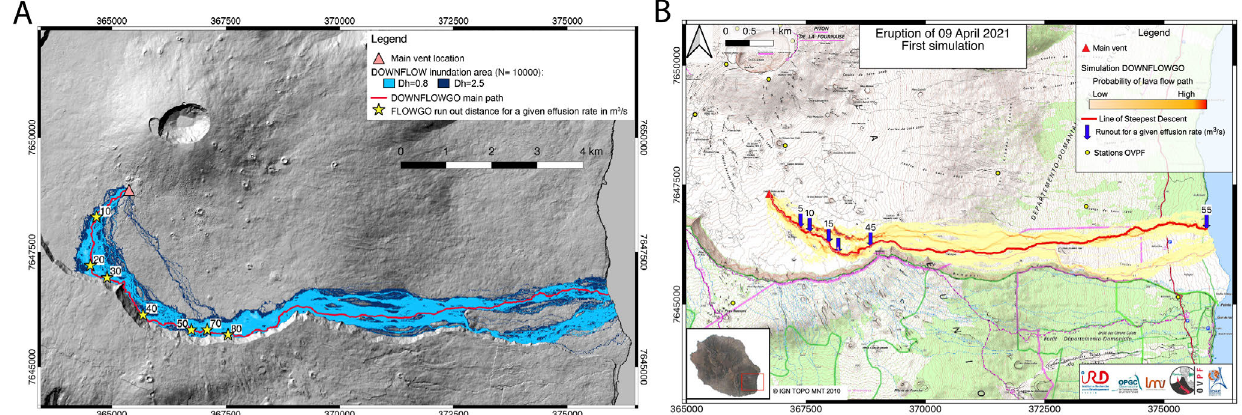
Figure 8: [A] The first map produced during the April 2018 eruption showing the lava flow inundation area (simulation with Δ h = 0.8 in light blue and Δ h = 2.5 in dark blue) and run out distances (yellow stars) for a given TADRs (numbers are in m 3 s − 1 ) along the LoSD descent (red line). The background is the hill-shaded 2010 LiDAR DEM produced by Institut national de l’information géo- graphique et forestière (IGN). [B] Map produced during the April 2021 eruption showing the lava flow inundation area (probability increases from yellow to red; Δ h = 2 and N = 10,000) and runout distances (blue arrows) for given discharge rate (numbers are in m 3 s − 1 ) along the LoSD (red line). The background is the BD TOPO IGN® from